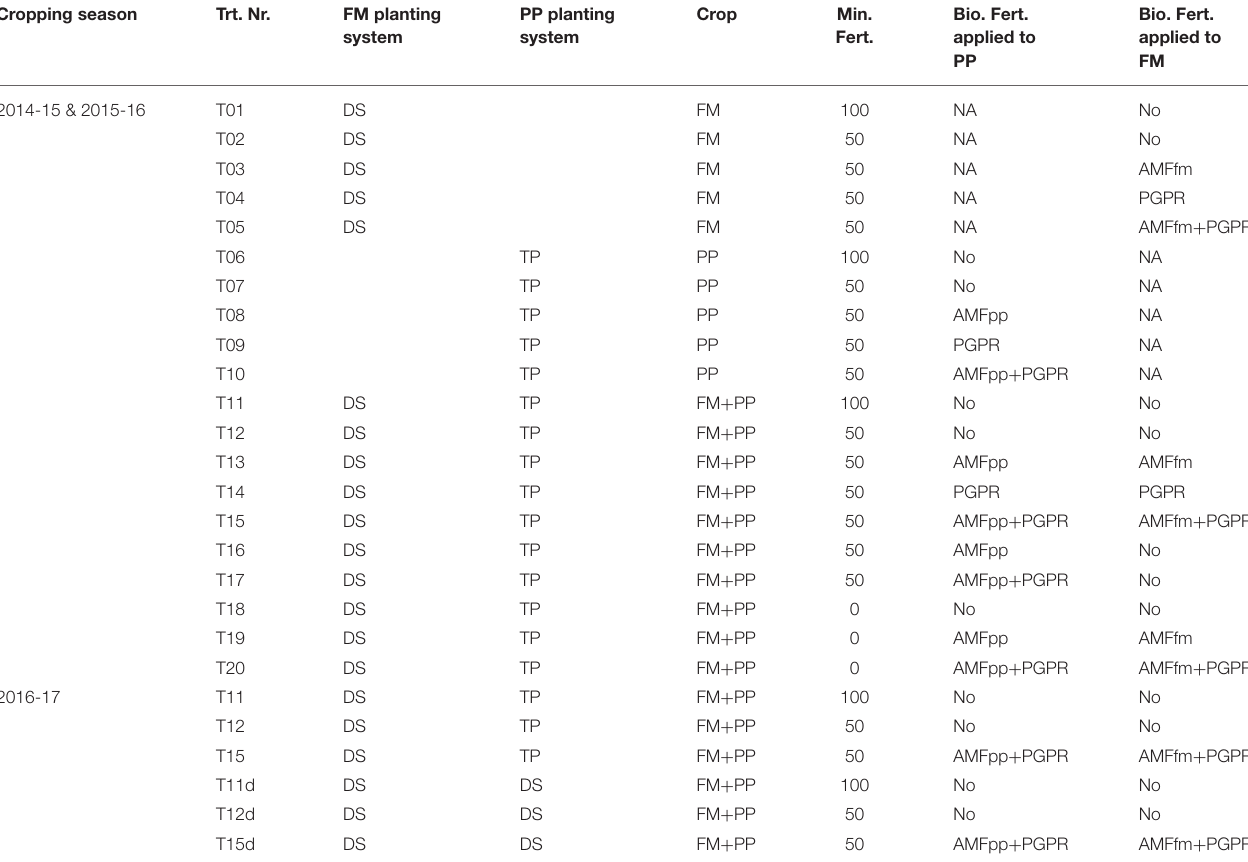
TABLE 1 | An overview of the 20 treatments in cropping seasons 2014-15 and 2015-16 and the six treatments in season 2016-17. Cropping season Trt. Nr. Crop